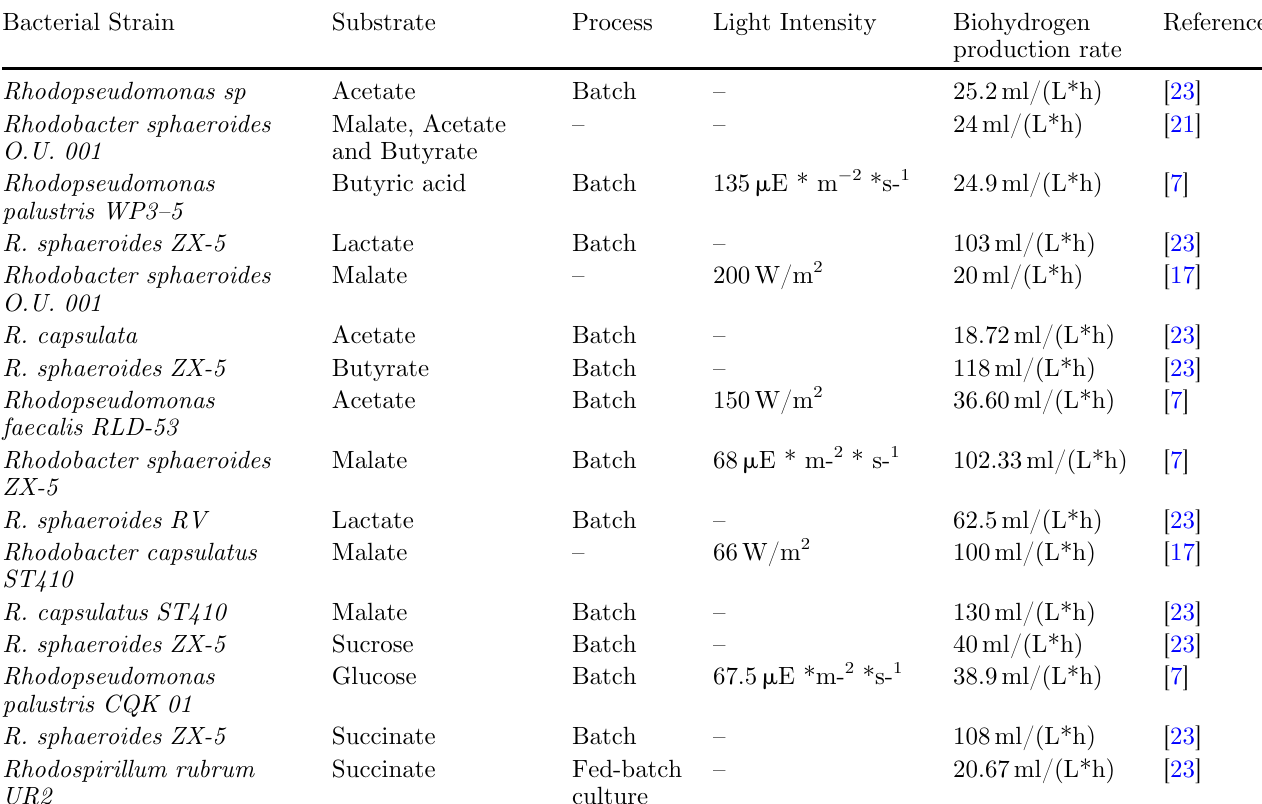
Table 15. Biohydrogen production rates from PNS bacteria according to